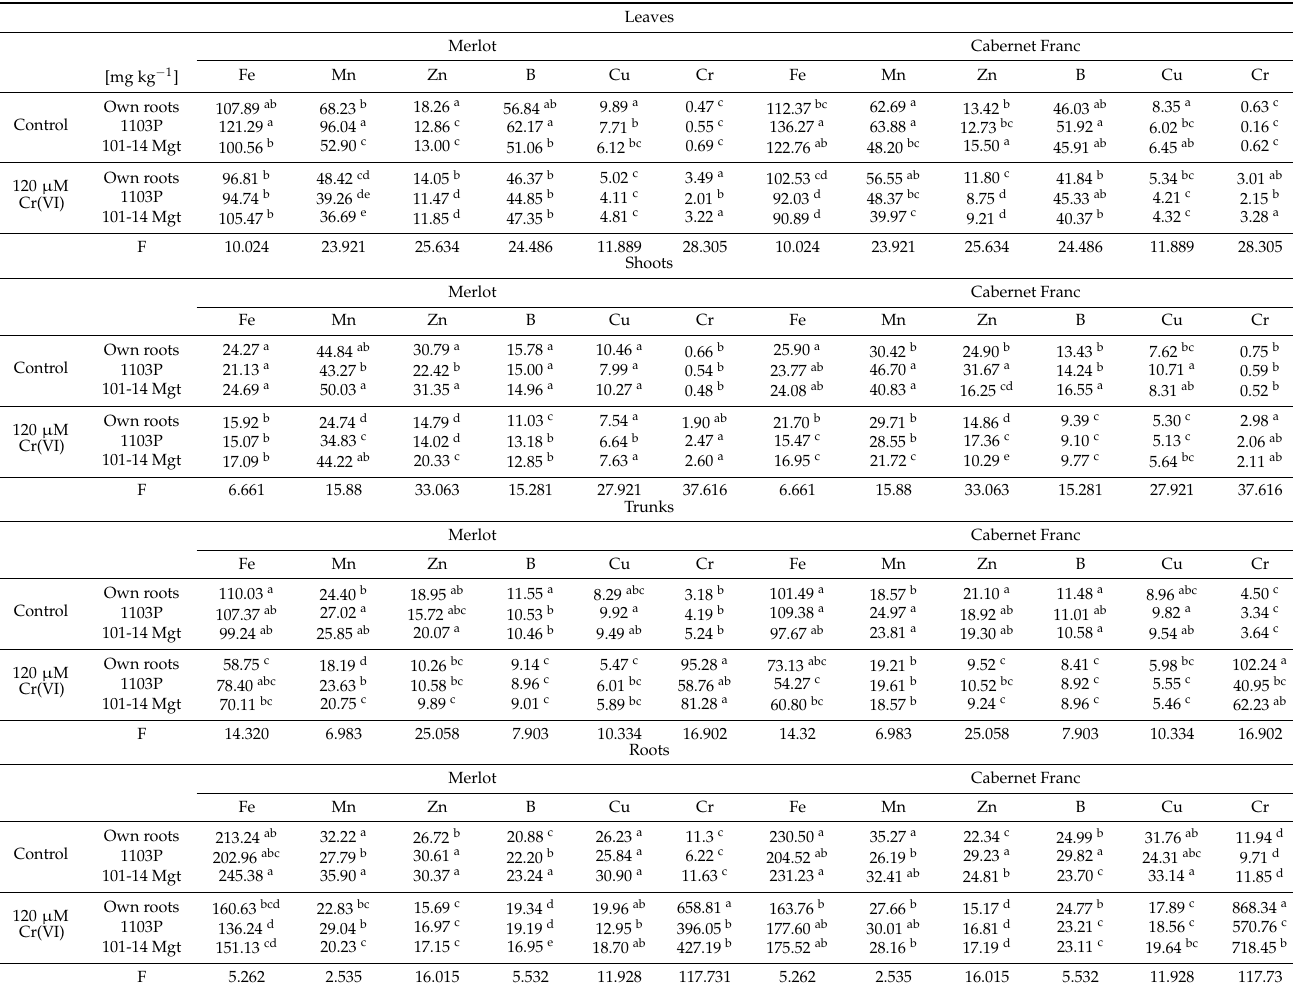
Table 3. The effect of Cr(VI) toxicity on micronutrient and metal (Fe, Mn, Zn, B, Cu, and Cr) concentrations in different parts of Merlot and Cabernet Franc vines on own roots or grafted to 1103P and 101-14 Mgt